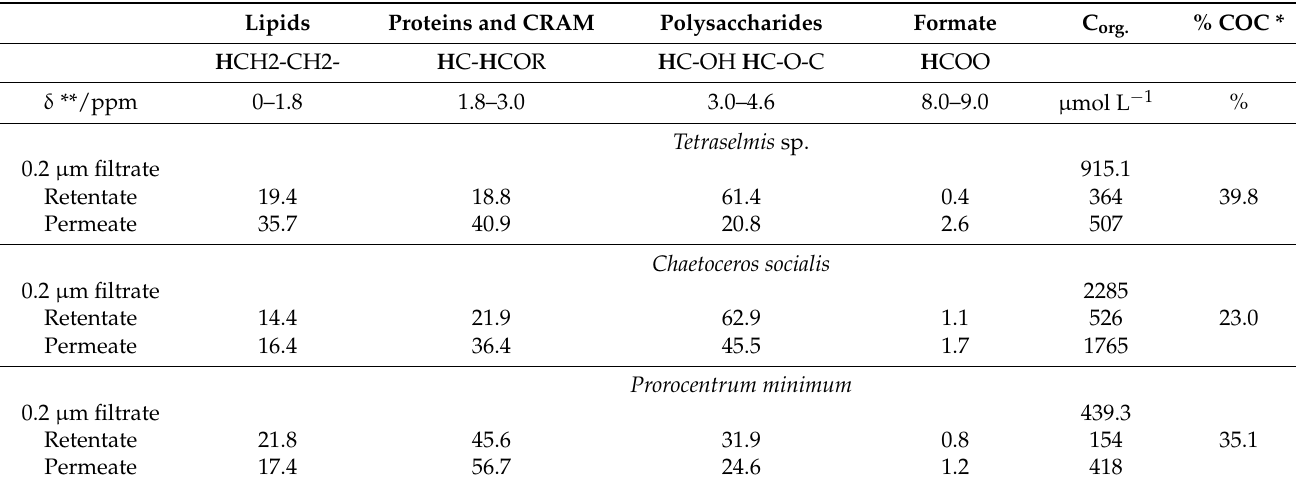
Table 2. Distribution of the integrated main groups of proton resonances (lipids, proteins and carboxyl-rich alicyclic molecules (CRAM), polysaccharides and formate) in 1 H MNR spectra (6/ppm), concentrations of C org. ( µ mol L − 1 ) in retentates and permeates and % COC from exudates of cultured phytoplankters. Protons that resonated in certain chemical shift range of integrated main groups are in bold (second row). Summarized from Klun et al.